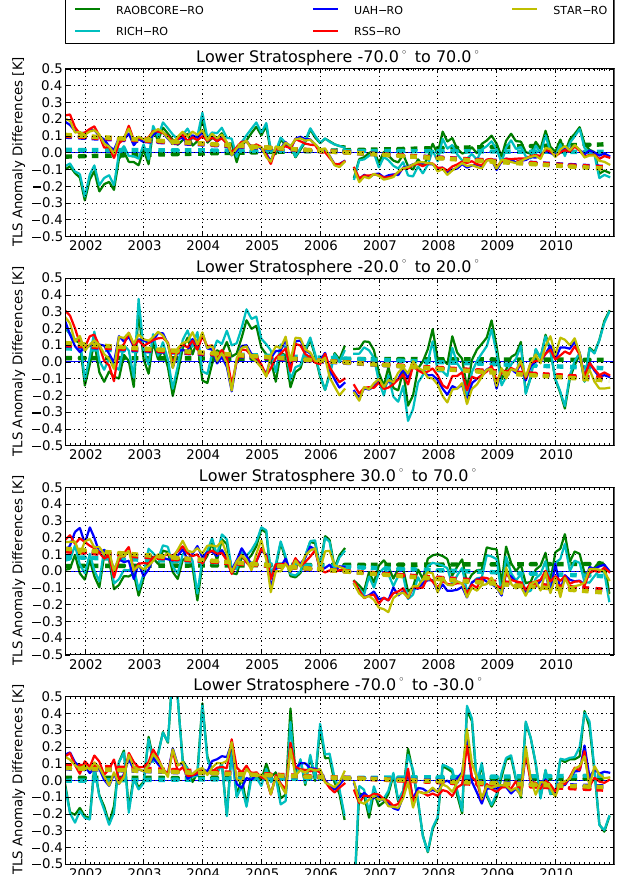
Fig. 10. TLS anomaly difference time series for all datasets, shown for quasi-global, tropical, and NH/SH extratropical zonal bands (top to bottom). The linear regression lines are shown as dashed